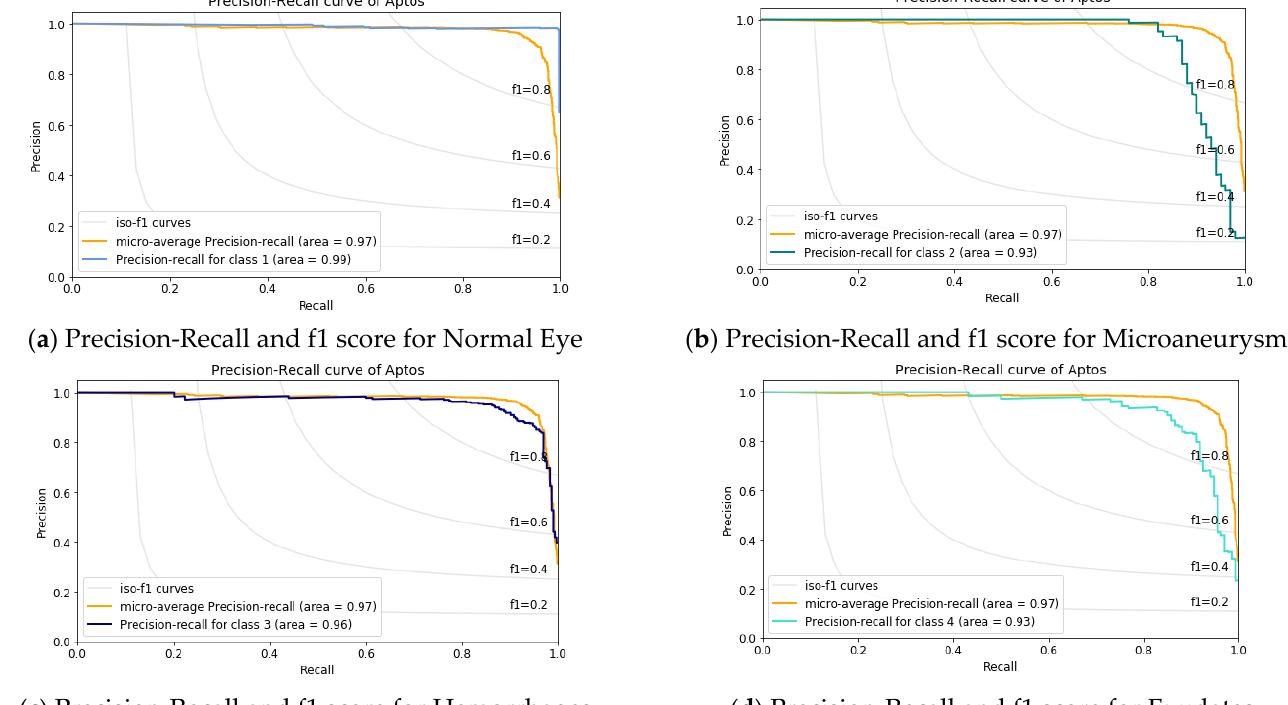
Figure 7. Precision-Recall and f1 score analysis for APTOS dataset.